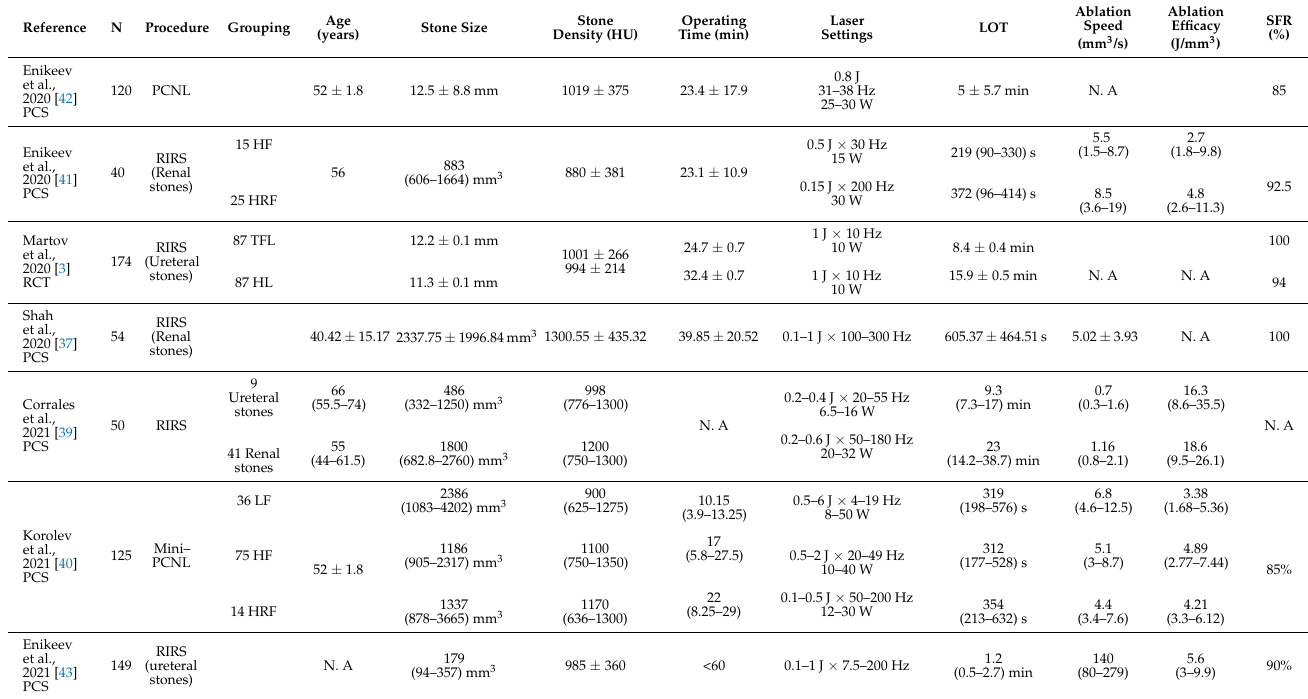
Table 2. Full-text TFL clinical